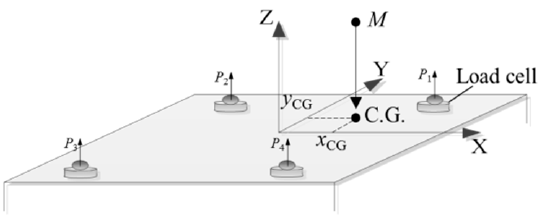
Figure 1. The principle diagram of the mass and centroid measurement.